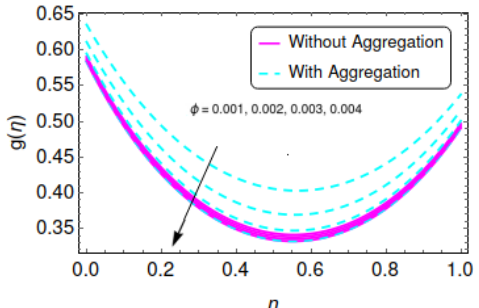
Figure 21. Characteristics of φ for g ( η )